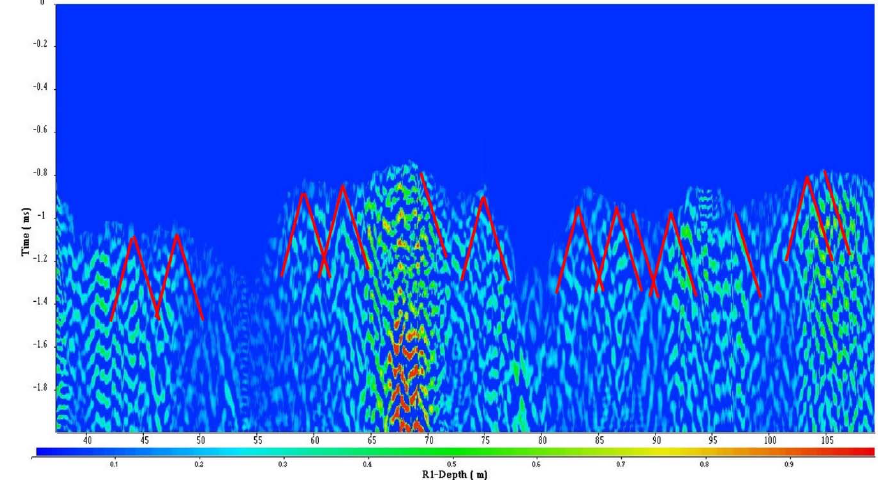
Figure 16. Focus on the noise space section presented in Figure 15b. The red lines highlight some criss-cross events.